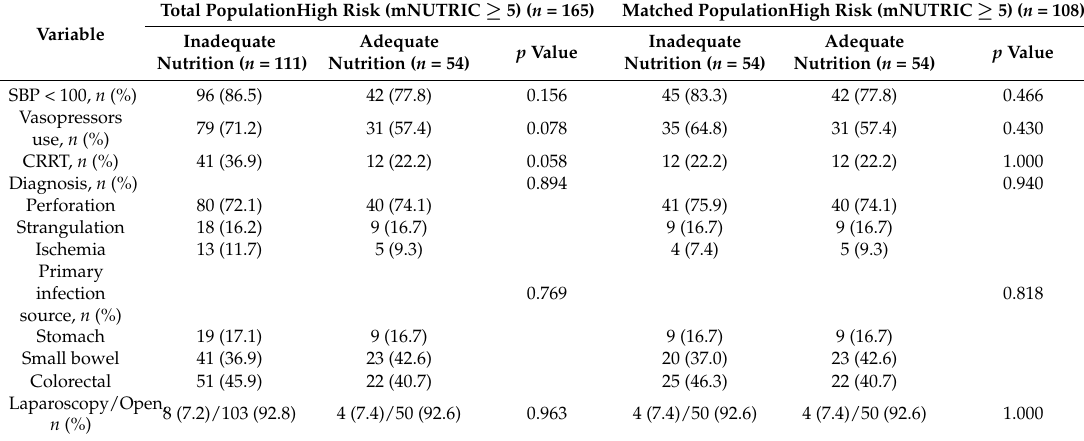
Table 2. Perioperative parameters of patients with high mNUTRIC scores.